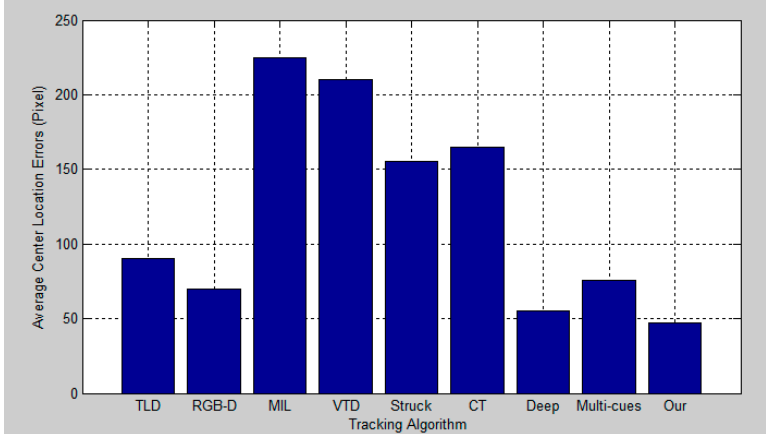
Figure 14. Quantitative evaluation in terms of average center location error (in pixel) for the third experiment.